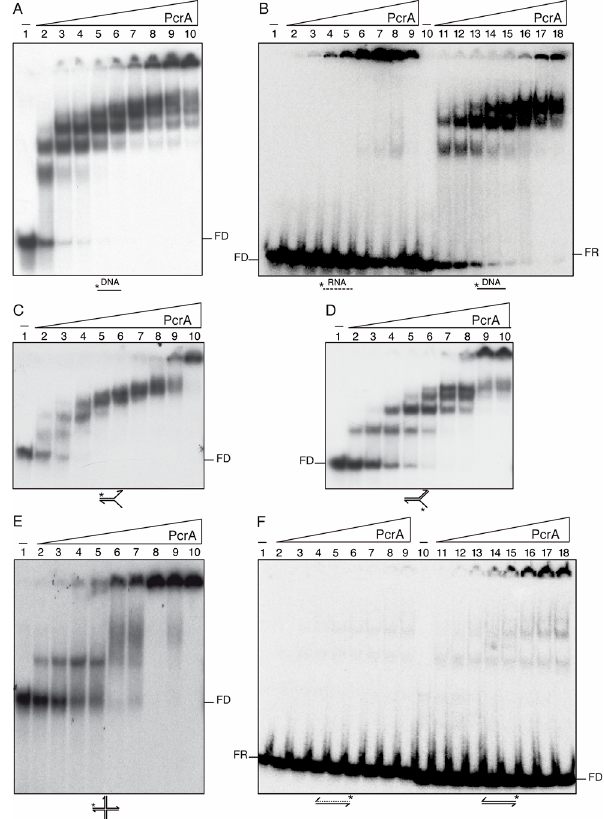
Figure 3. PcrA preferentially binds ssDNA and to a less extent RNA. Increasing concentrations of PcrA (3 to 400 nM ( A , B , E , F ) or 0.3 to 100 ( C , D )) were incubated with a 100-nt long [ γ 32 P]-ssDNA ( A ), 38-nt long [ γ 32 P]-RNA or ssDNA ( B ), 60-nt long [ γ 32 P]-flayed DNA (30-nt tails and 30-bp duplex) ( C ), [ γ 32 P]-3 ′ -fork DNA (30-nt 3 ′ -tail, and 30-bp duplex) ( D ), [ γ 32 P]-HJ3 DNA ( E ), and 38-bp long [ γ 32 P]-duplex DNA or RNA ( F ) in buffer D containing 2.5 mM ATP γ S (15 min, 37 °C). Protein-DNA complexes were analyzed by 5% PAGE in 0.25× TBE buffer and autoradiography. K Dapp values were obtained from EMSA assays after electrophoresis. A straight line represents DNA and a dotted line RNA. Abbreviation, FD, free-DNA; FR, free-RNA; * denotes the [ γ 32 P]-labeled strand. A mobile HJ DNA has four duplex arms with a central ssDNA region at the junction.